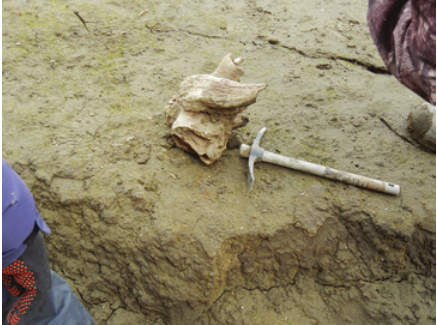
Figure 8 Muskox skull, Siberia (Source: photograph by Julian Murton, Project Collaborator at the University of